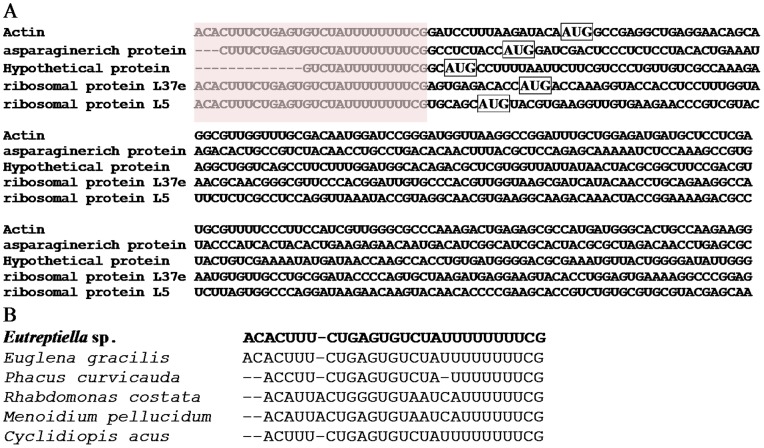
Spliced Leader (SL) trans-splicing in Eutreptiella sp.(A) SL sequence found in five Eutreptiella cDNAs. The 28-nt identical SL is shaded. The potential start codon ATG is boxed. (B.) SL in Eutreptiella sp. (bold-typed) and other euglenoids (reported by Frantz et al. [17]).